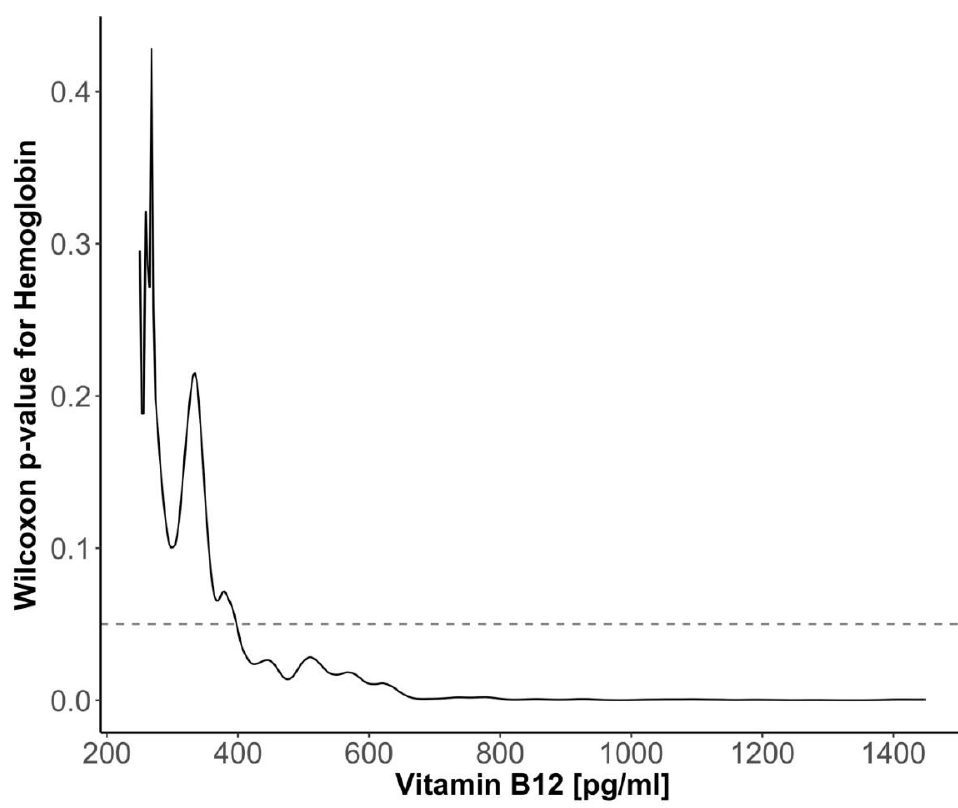
Figure 3. The Wilcoxon p -value for the significance of differences in hemoglobin concentration in samples continuously divided according to different vitamin B 12 concentration (floating B 12 cut-off), dashed line designates the level of significance 0.05.